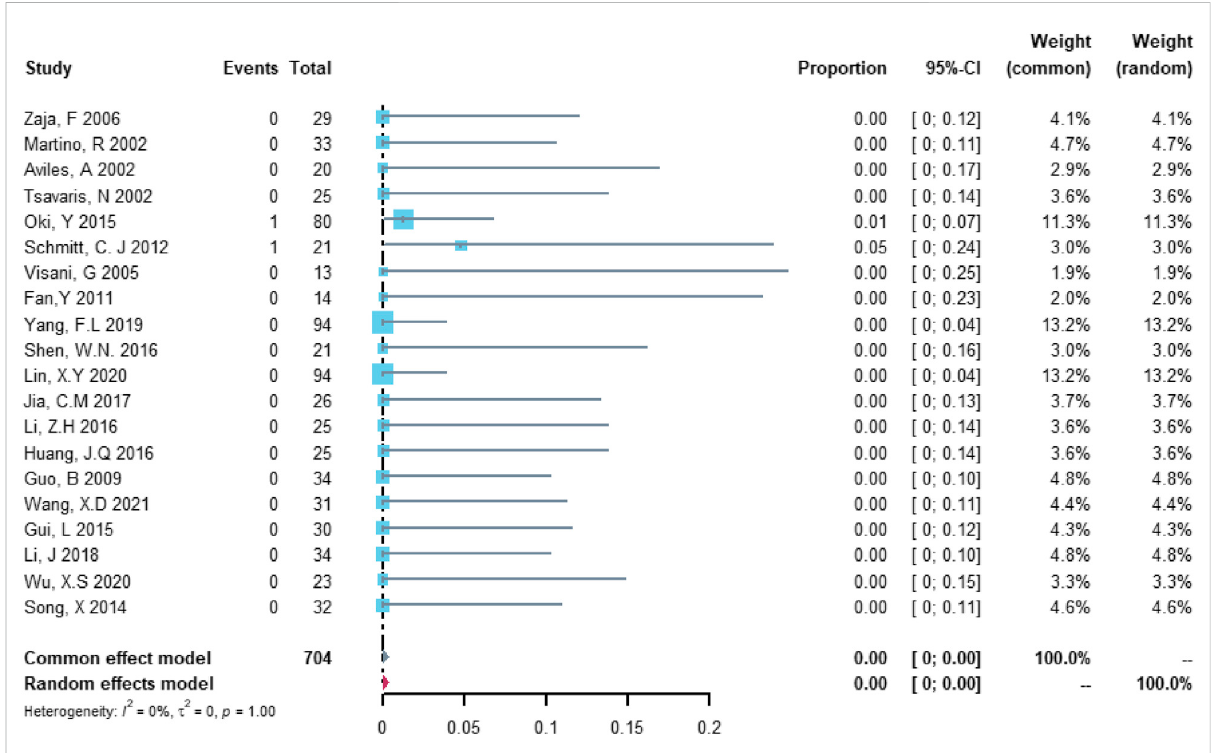
FIGURE 7 Summary pooled proportion analysis of cardiovascular death events associated with the (R)-CDOP combination